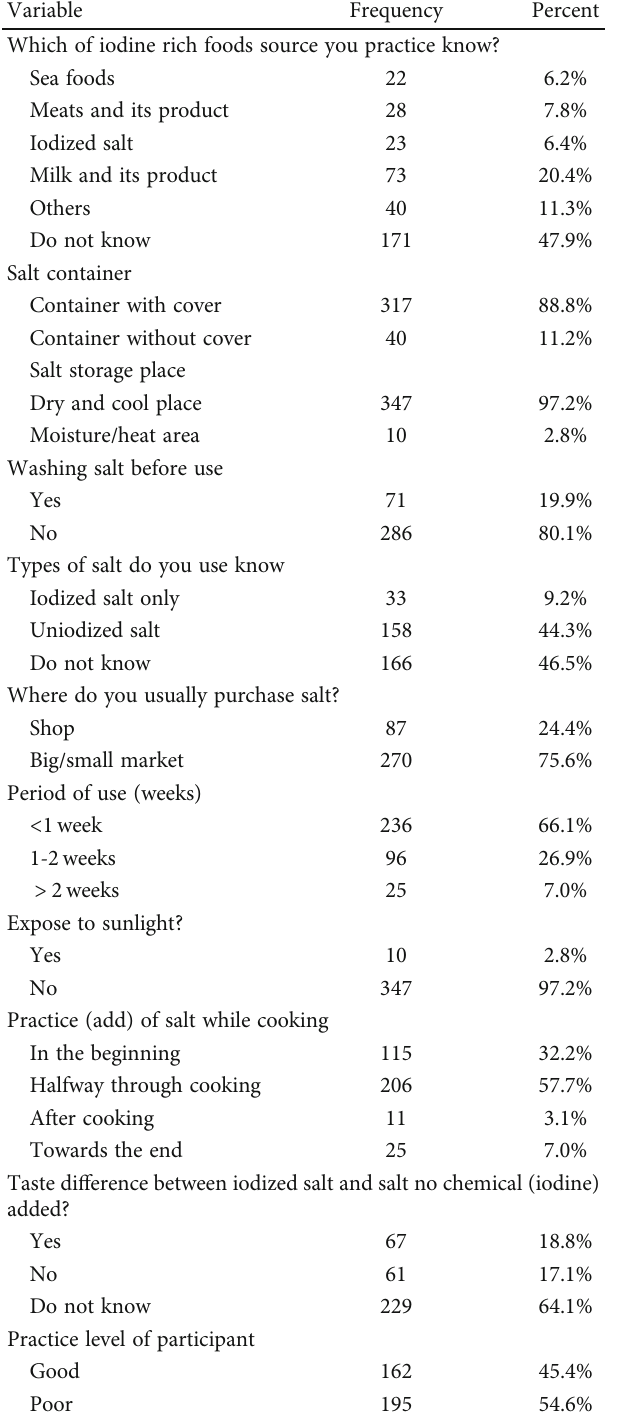
Table 3: Frequency distribution of respondents ’ about practice of iodized salt in the study area.